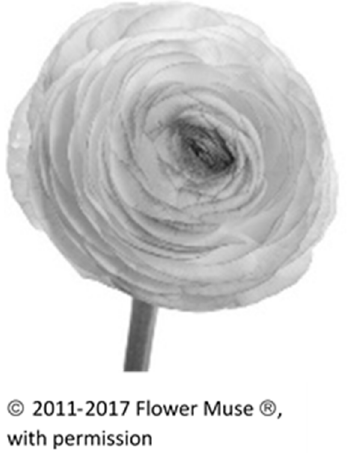
Figure 4. Rananculus.